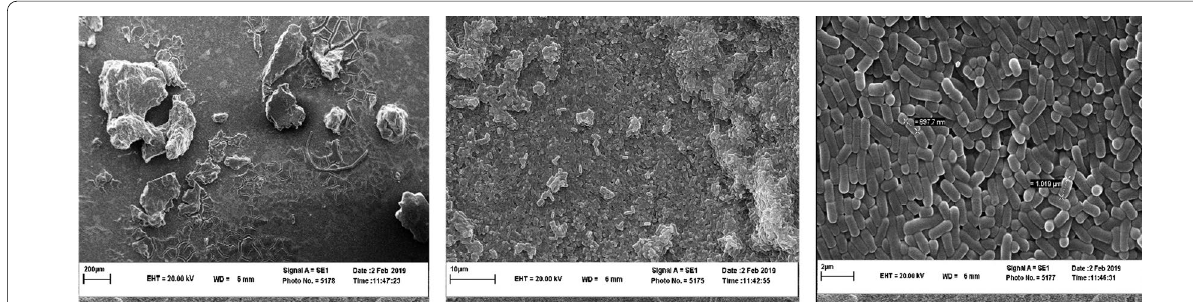
Fig. 5 Scanning electron microscopy images of biofilm-forming L. plantarum in